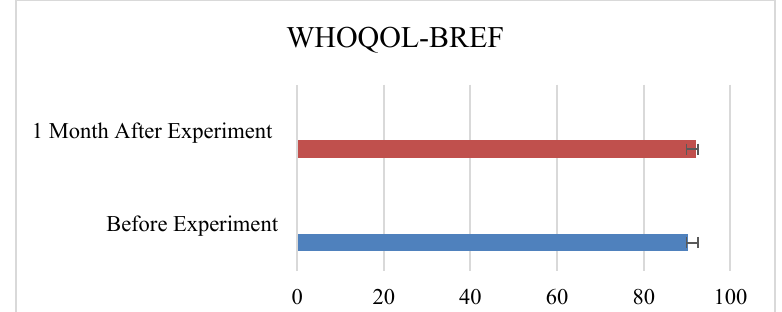
Figure 8. Comparison of the results of the WHOQO-BREF subscale before the experiment and one month after the